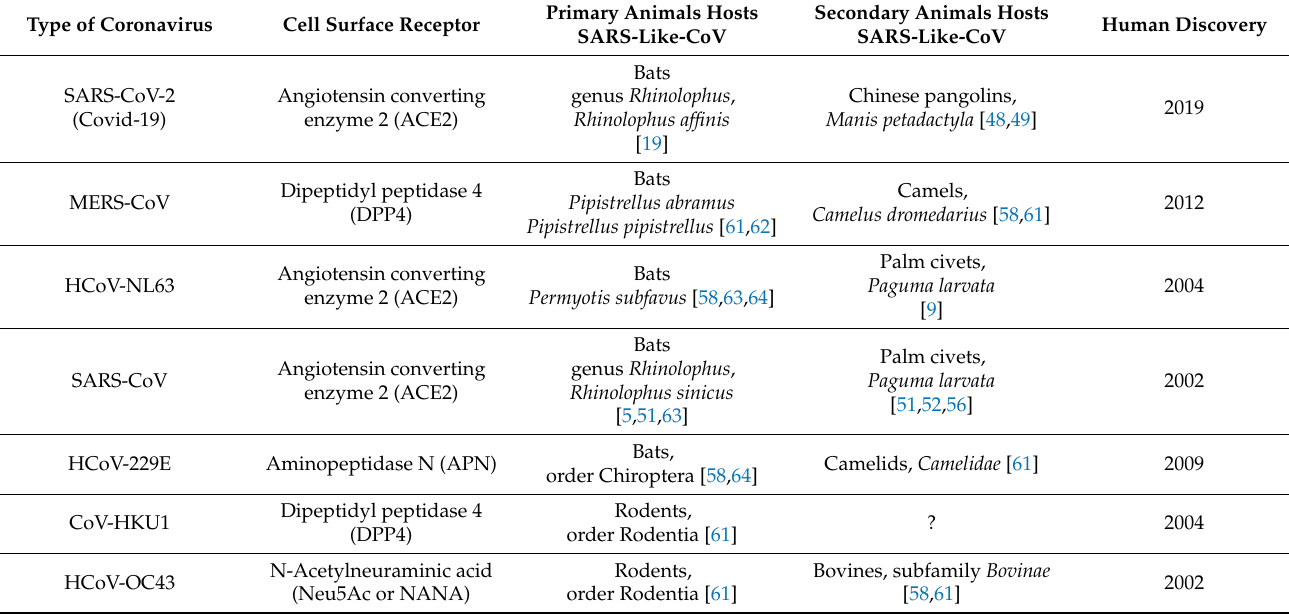
Table 1. Comparison of human coronaviruses and natural animal hosts and cellular receptors for viral entry. Type of